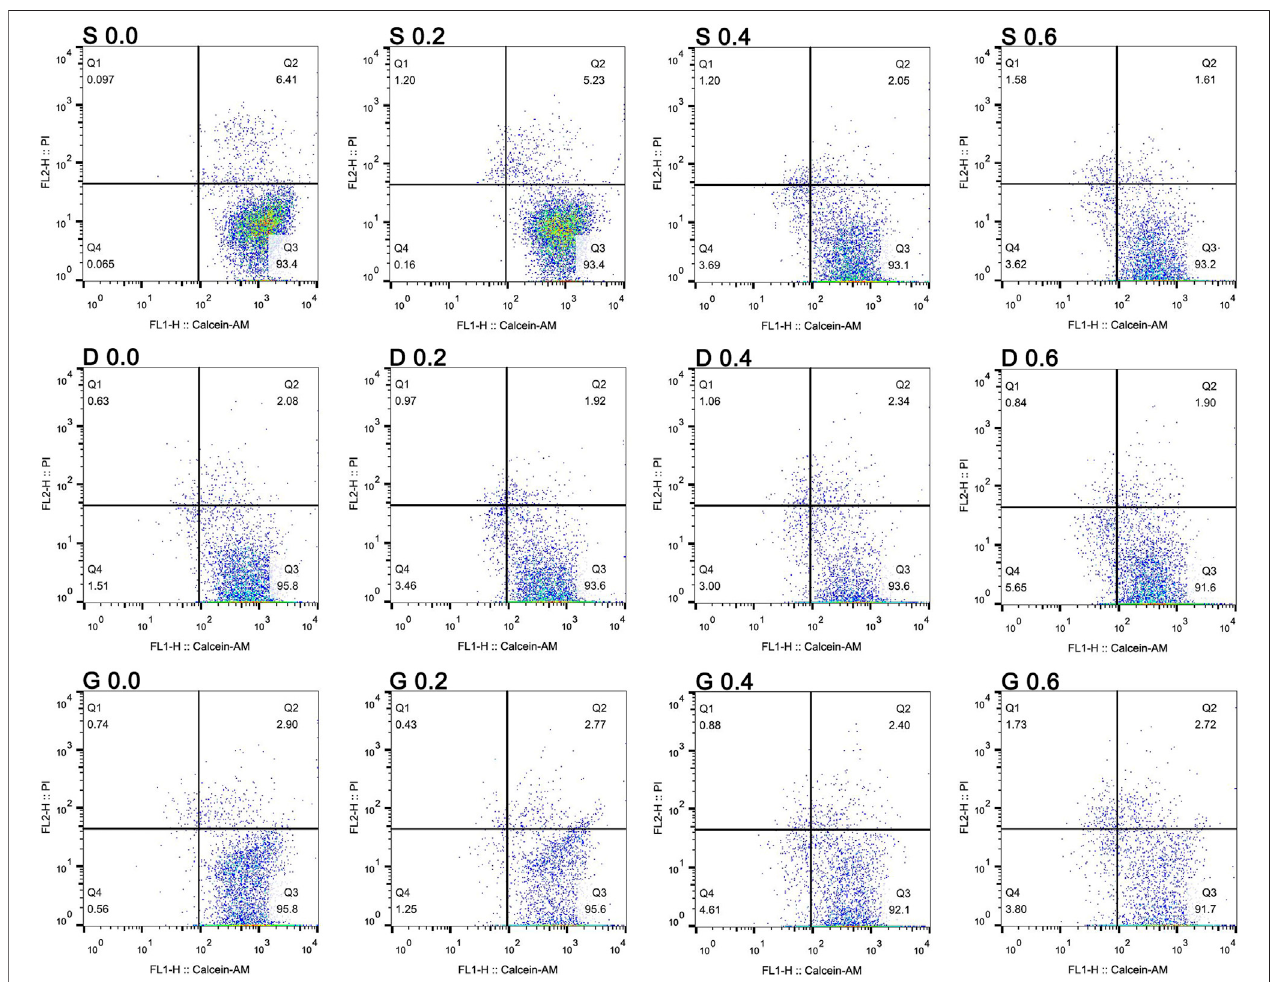
FIGURE 11 | The live/dead assay of rMSCs on scaffolds with varied TPMS architectures after 7 days of co-colture.